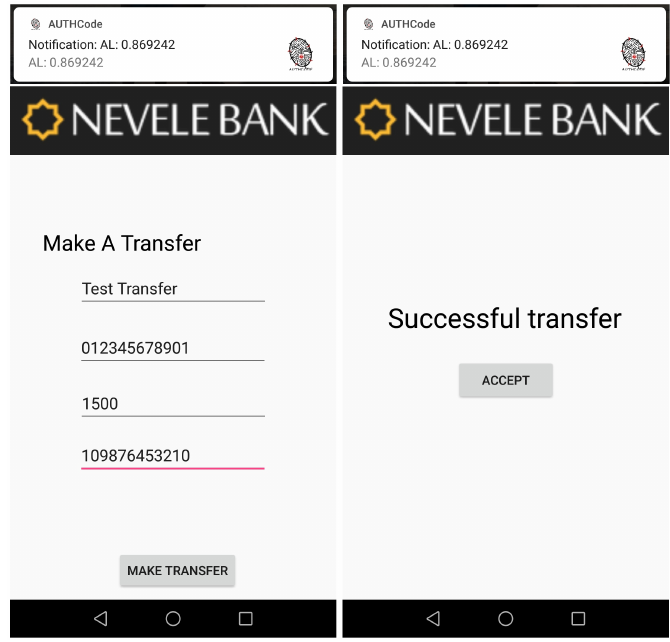
Figure 14. UserA using the online banking application with full